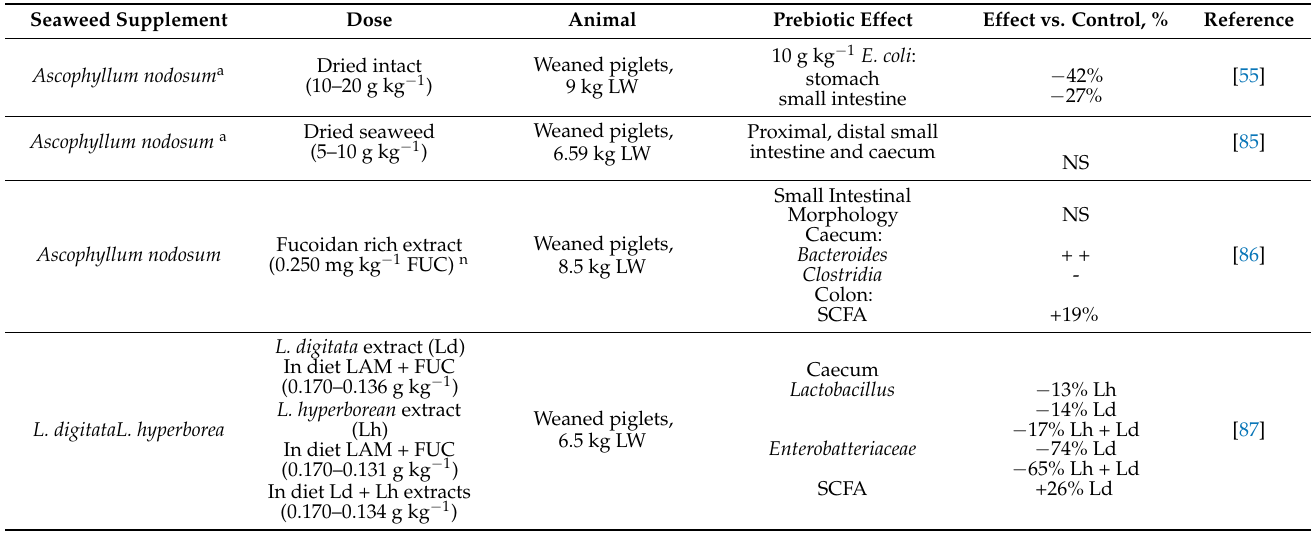
Table 4. Prebiotic effects of seaweed in weaned